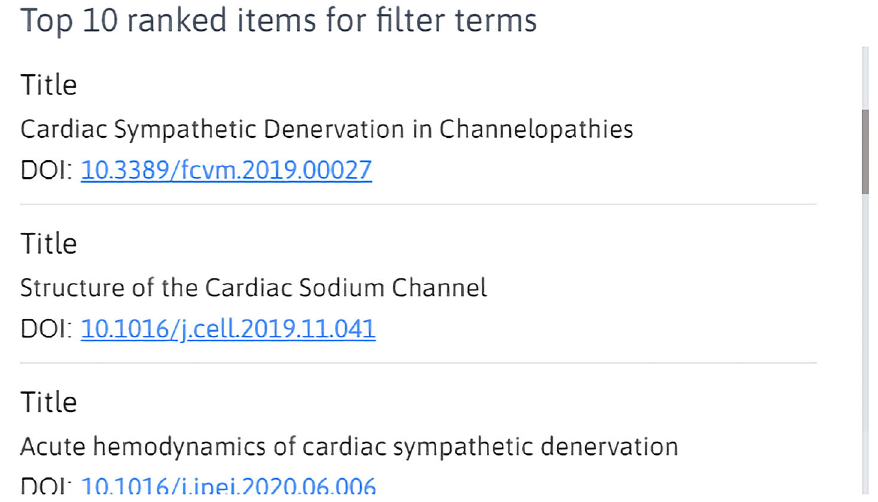
Figure 6. A list of resources that are recommended by SPARClink when a search term filter is provided by the